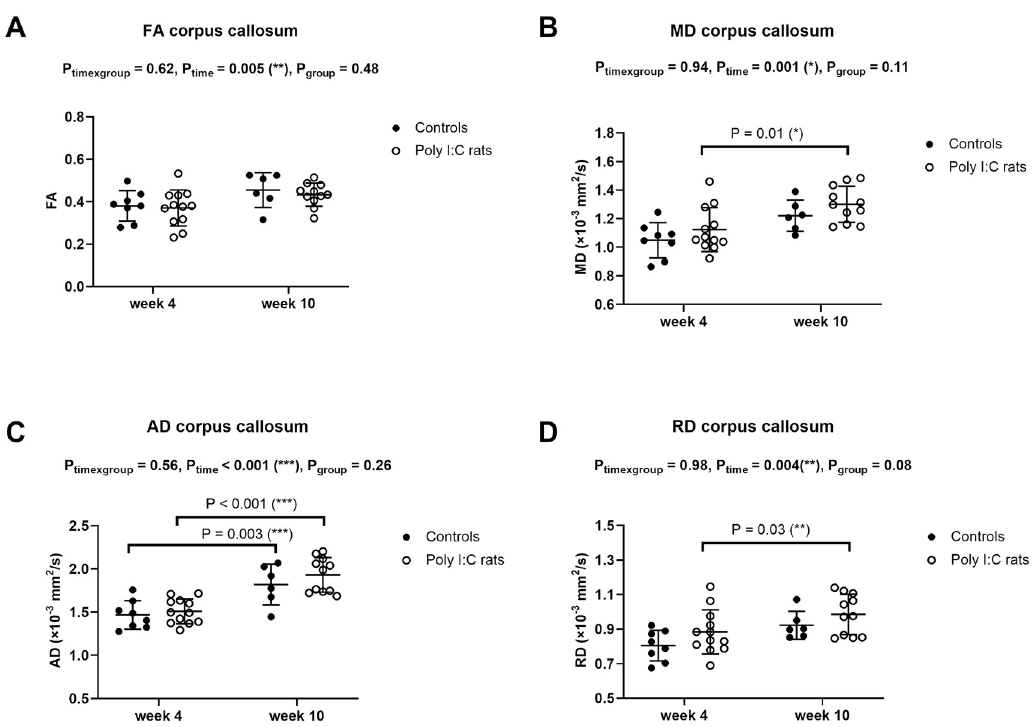
Fig 4. Corpus callosum MR diffusion properties (mean ± standard deviation) in controls (•) and poly (I:C) rats ( � ) measured at 4 and 10 weeks after birth. (A) Fractional anisotropy—FA, (B) Mean diffusivity–MD, (C) Axial diffusivity–AD, and (D) Radial diffusivity–RD. MD, RD and AD increased with age in poly (I:C) rats, while only AD increased from week 4 to week 10 in controls. FA of the corpus callosum did not differ between groups and did not change with age. Data were analyzed with a mixed- effects model with Sidak’s multiple